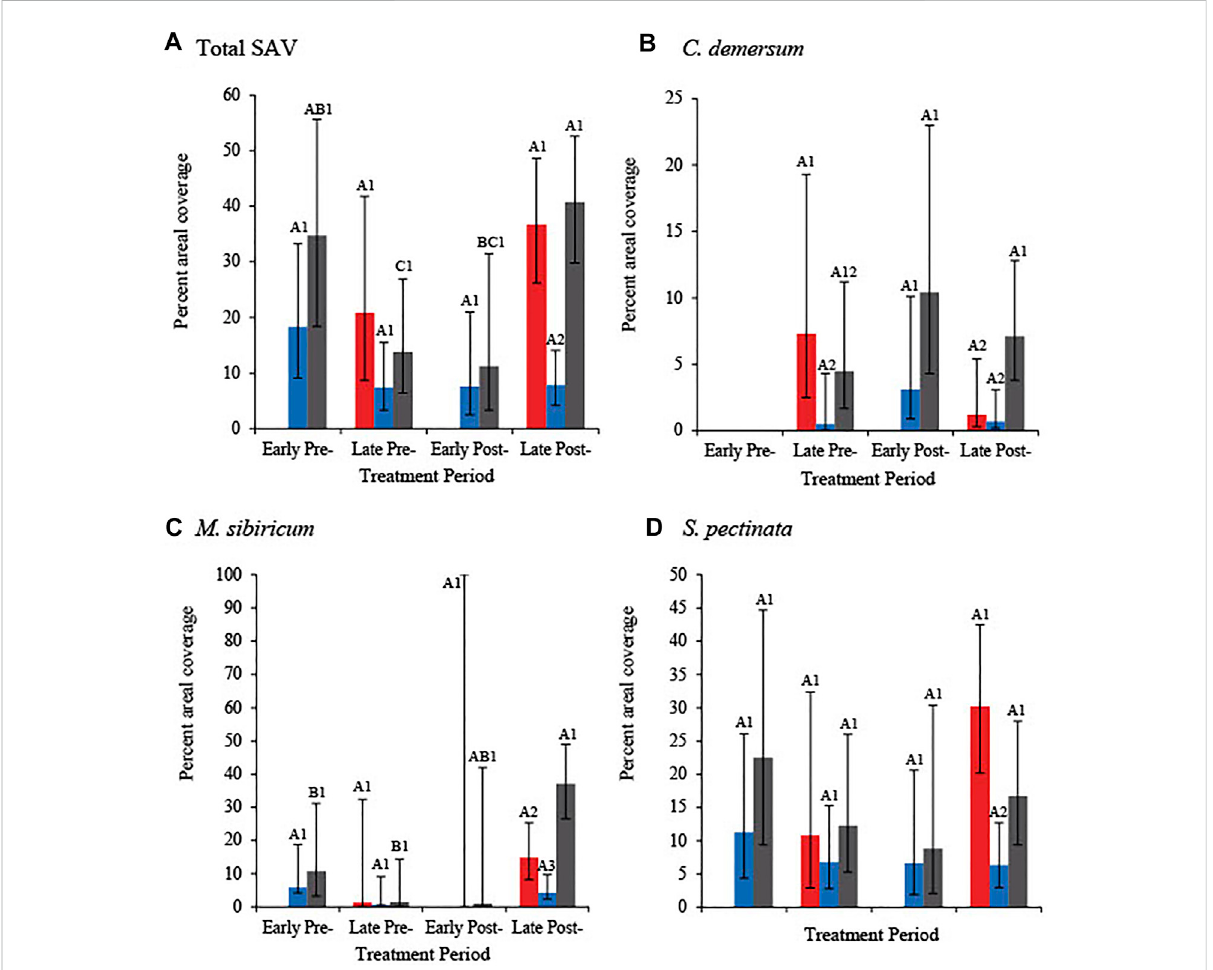
FIGURE 6 Percent cover and 95% con fi dence intervals of (A) total submersed aquatic vegetation (SAV) and the three most common SAV species [ (B) Ceratophyllum demersum , (C) Myriophyllum sibiricum , and (D) Stuckenia pectinata ] in SAV mapping transects and 1 – 4 in the west (red), 7 – 13 in the east 1 (blue), and 14 – 17 in the east 2 (grey) carp exclusion units, Delta Marsh, Manitoba. Treatment periods are de fi ned as: early pre-carp exclusion (1974), late pre-carp exclusion (1997, 2009 – 2010), early post-carp exclusion (2014), and late post-carp exclusion (2016 – 2018). Percent cover included homogenous vegetation beds and mixed species bed assemblages where each species occurred. Different letters (A – C) indicate a statistical difference between treatment periods within the same species and unit. Different numbers (1 – 3) indicate a statistical difference between units within each SAV group (total SAV or species) and treatment